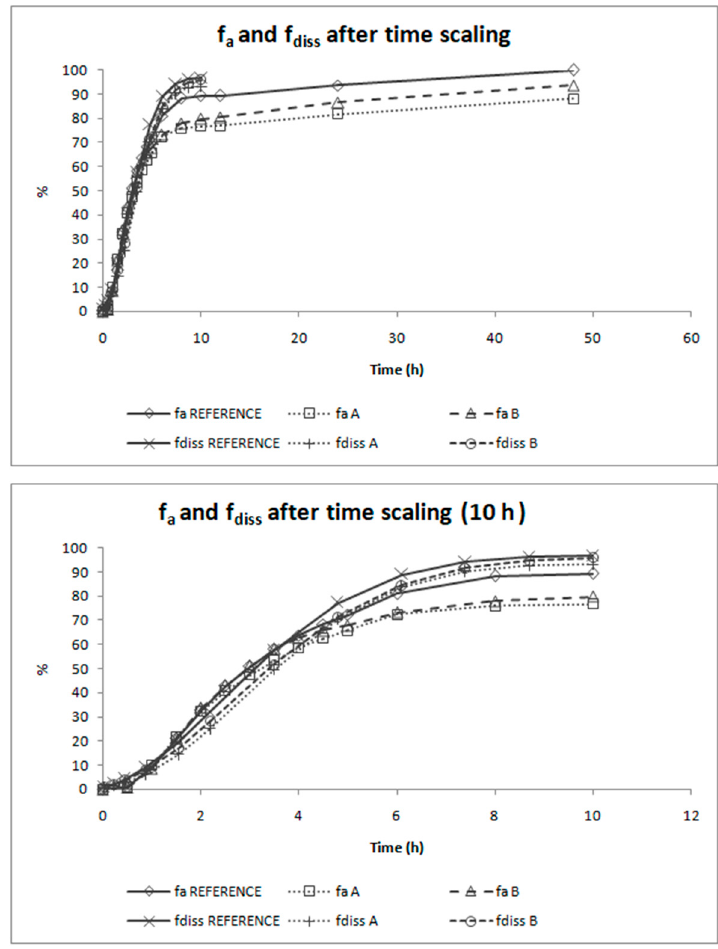
Figure 8. Absorption and dissolution profiles of the three formulations of candesartan cilexetil (Reference, Product A and Product B) after time scaling. The first panel shows the complete profiles and the second one is limited to time equal to 10 h to facilitate viewing the overlapping of the processes. f a = fraction absorbed, f diss = fraction dissolved.